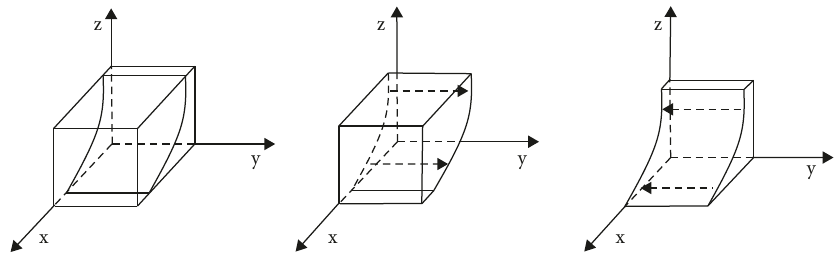
Figure 2: Dynamic replication phase diagram of the evolution of the whistleblower’s strategic